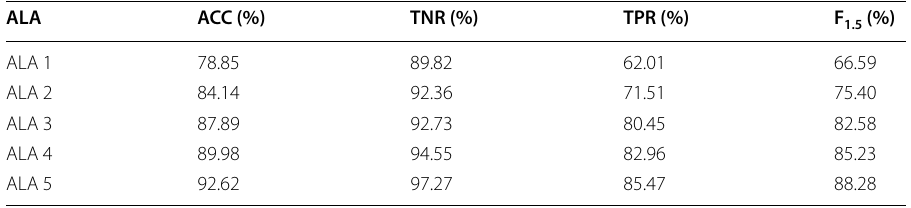
Table 2 Accuracy of the GAR model for Introduction to enterprise course ALA